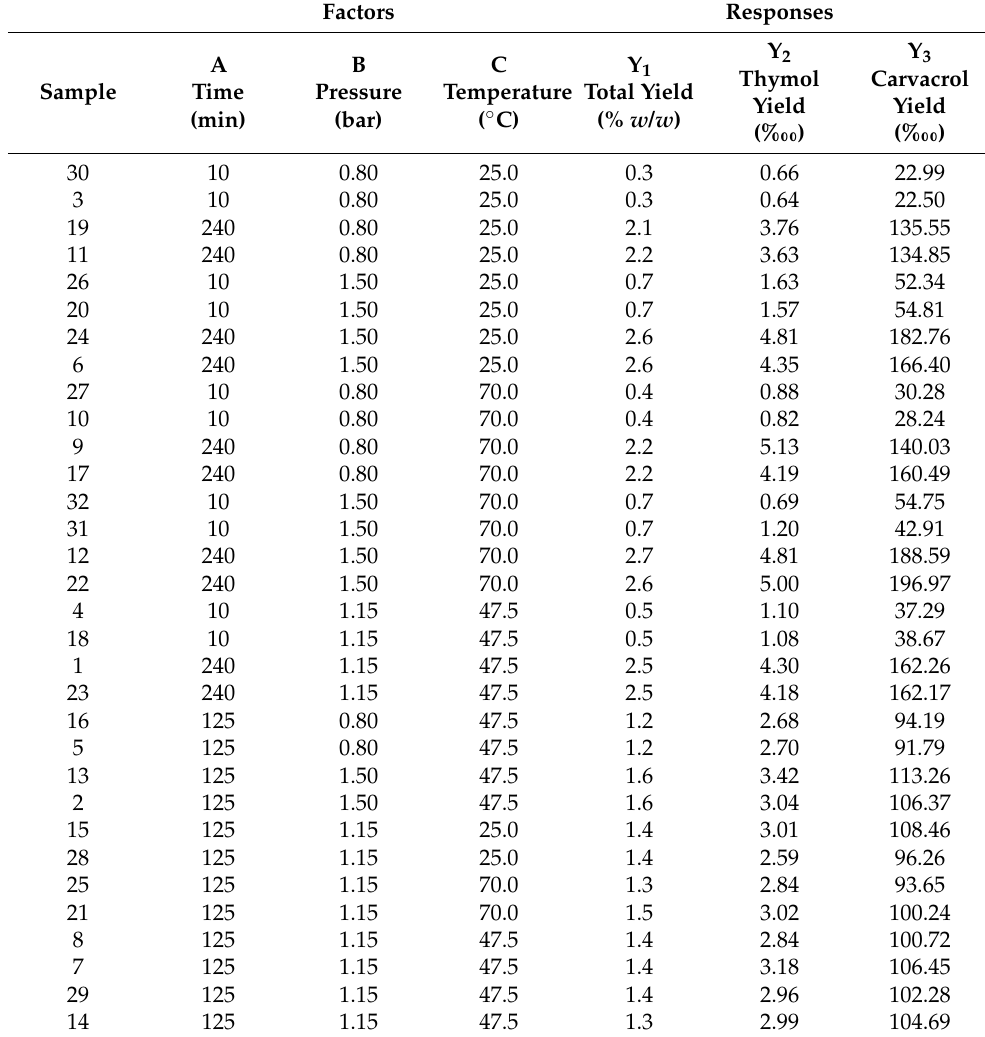
Table 1. Matrix and observed responses of the applied FCC experimental